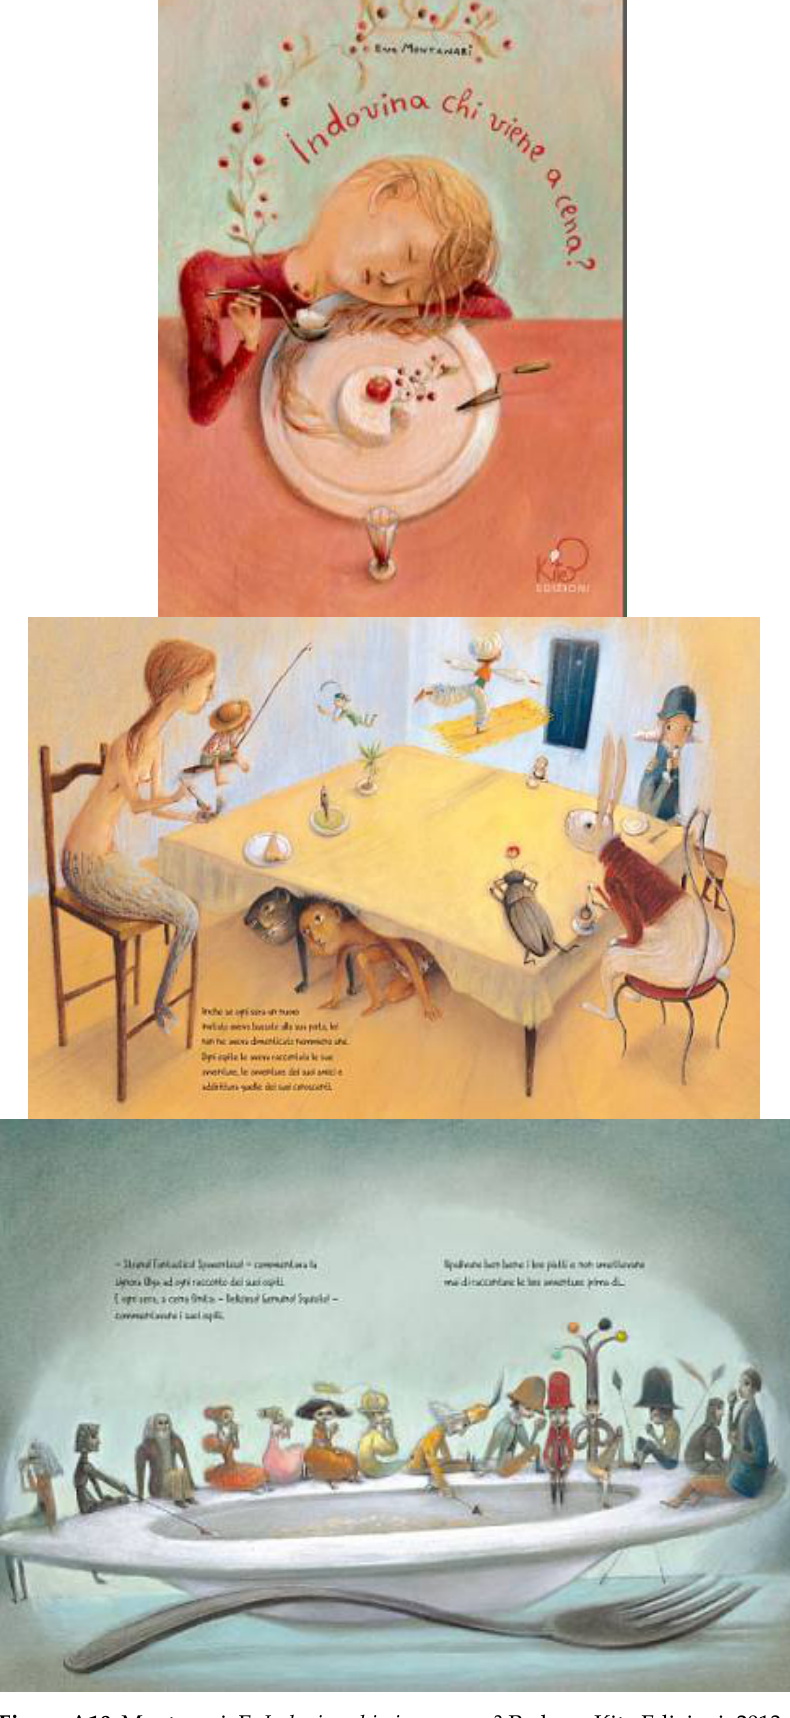
Figure A10. Montanari, E. Indovina chi viene a cena? Padova, Kite Edizioni,